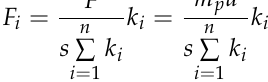
3 2 z ( sin θ ) with regard to V z and θ (source elaborated by Sf (cid:48) c sin θ